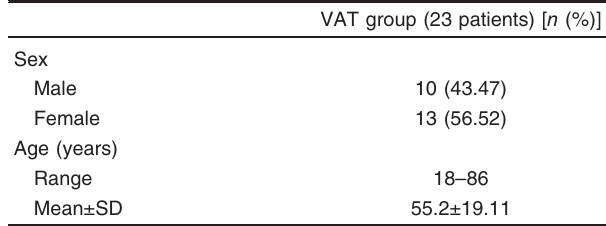
Table 1 Sex and age of ventilator-associated tracheobronchitis patients